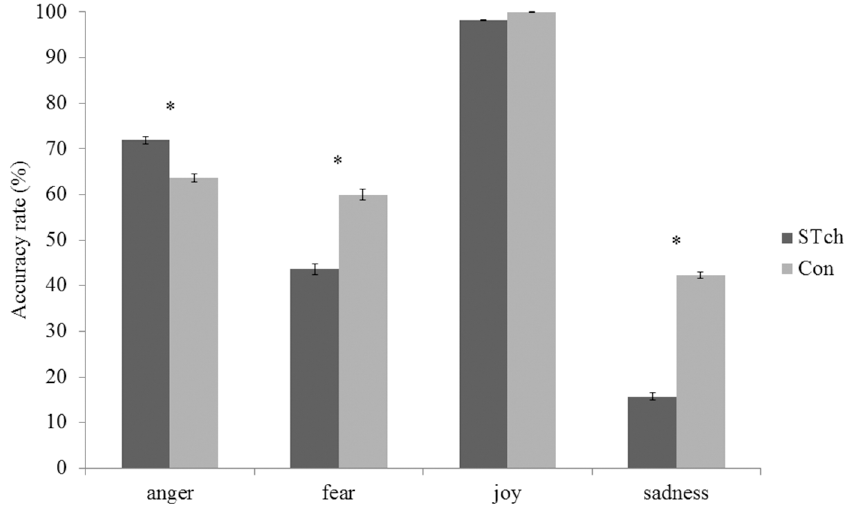
Fig 6. Accuracy rate. Accuracy rate for street-children (STch) and controls (Con). * = p < 0.004. Only differences between groups are shown. For differences inside each group, see text. Error bars represent SE.